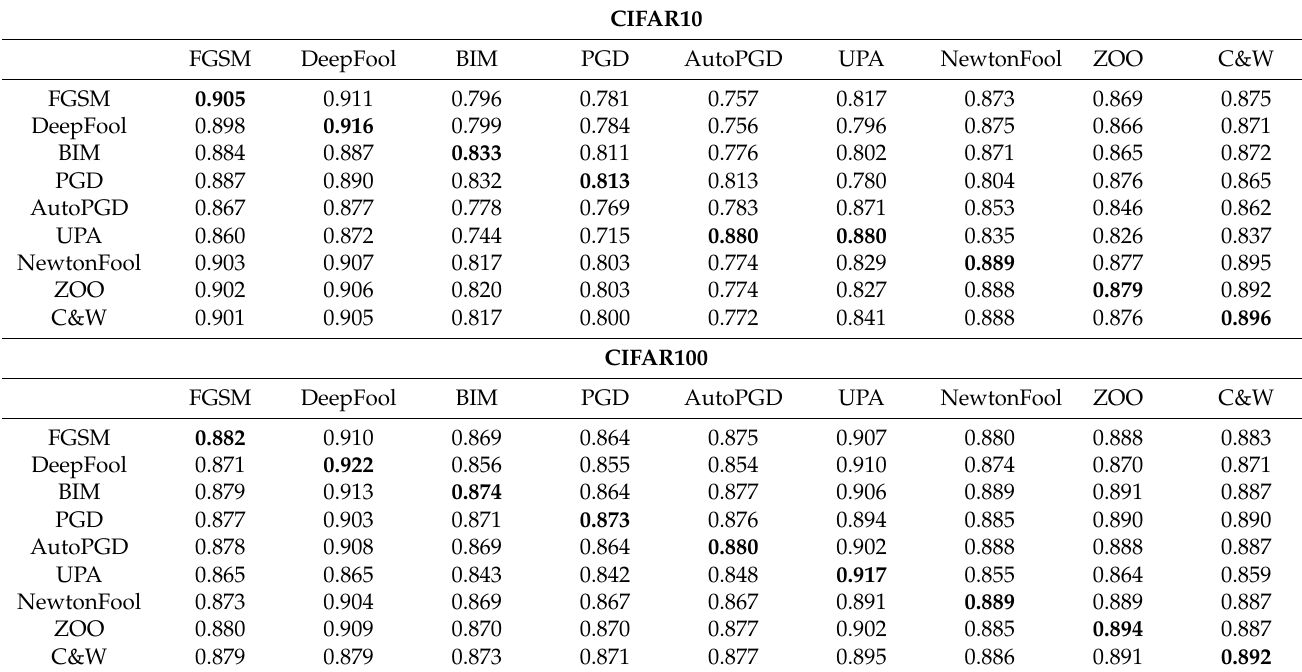
Table 1. The results of adversarial example detection (The vertical axis and the horizontal axis represent training and evaluation,